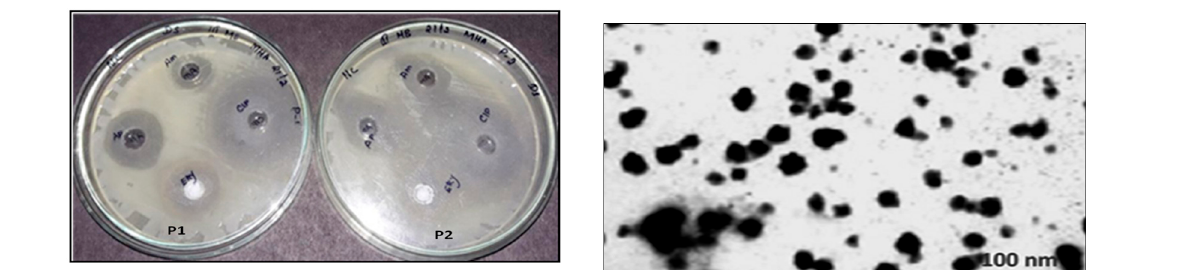
Fig. 5. The growth curve showing the various concentration of ciproflaxin conjugated chitosan nanoparticles and its effect on S.aureus .